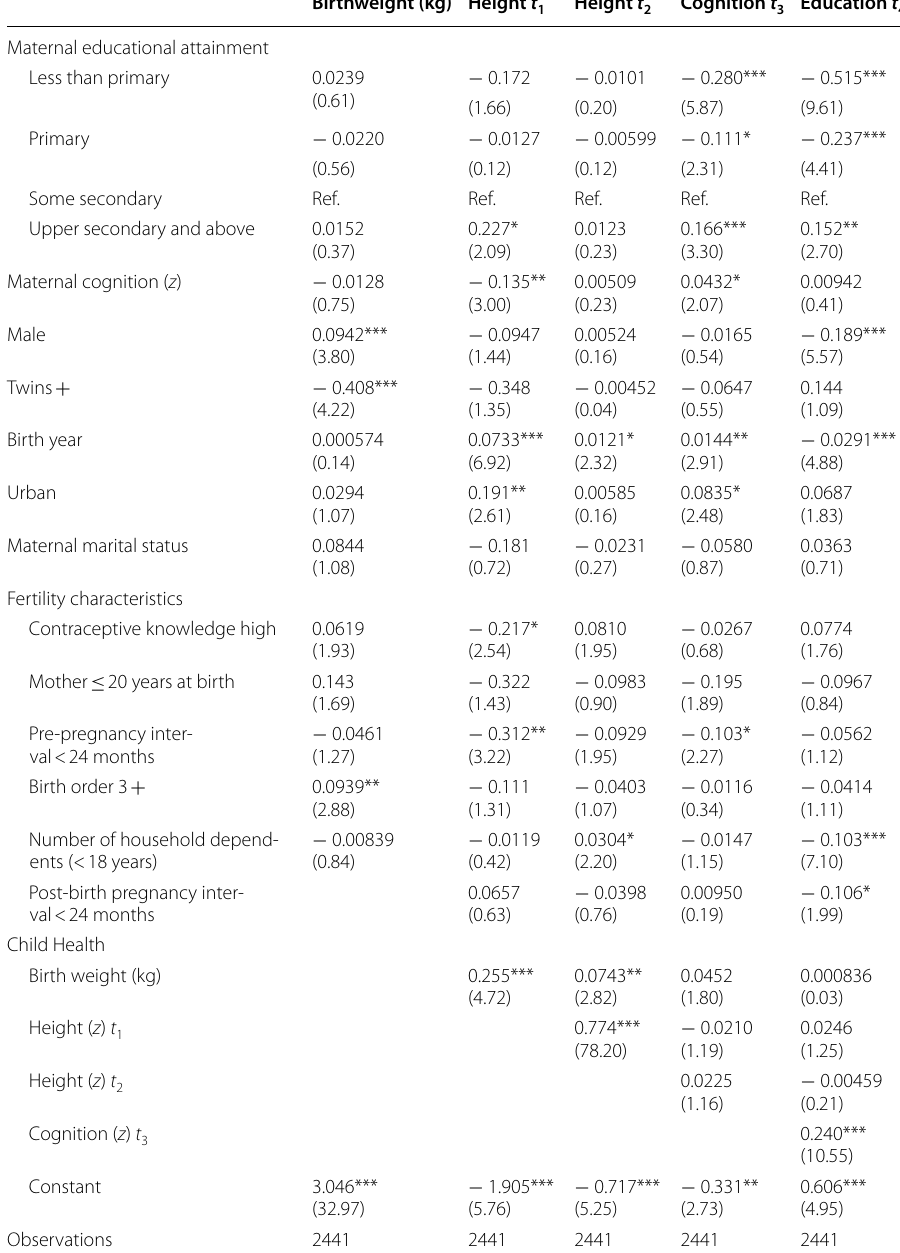
Table 3 Linear regression model coefficient estimates (standard errors) among non-first